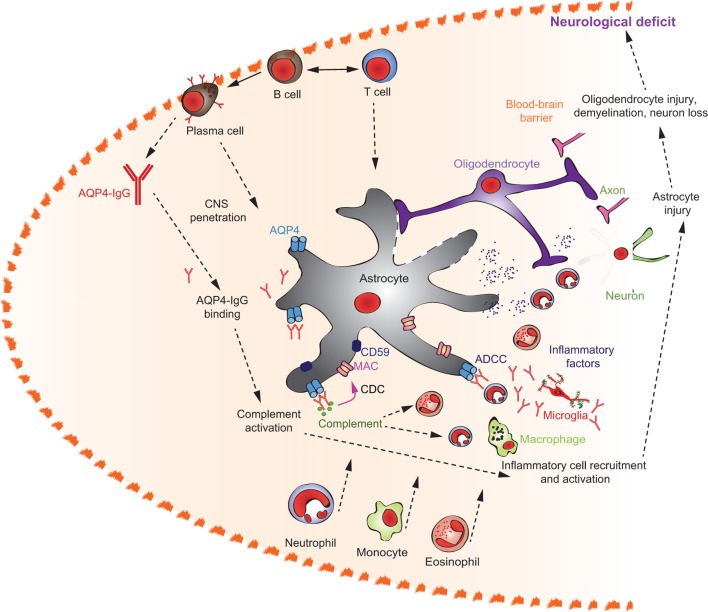
Neuromyelitis optica spectrum disorder pathogenesis mechanisms. Scheme shows astrocyte aquaporin-4 (AQP4) as the target of AQP4-IgG autoantibodies. Antibody binding initiates complement and cell-mediated cytotoxicity and an inflammatory response, resulting in oligodendrocyte injury and demyelination. Abbreviations: CDC, complement-dependent cytotoxicity; ADCC, antibody-dependent cellular cytotoxicity.